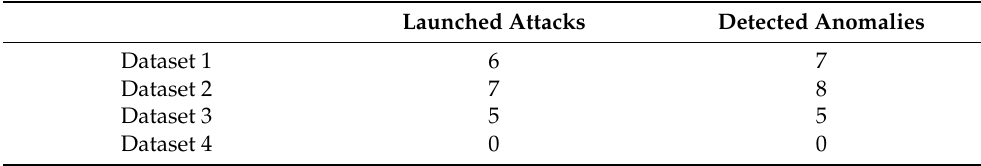
Table 7. Results of PLC-based whitelist system of trivial